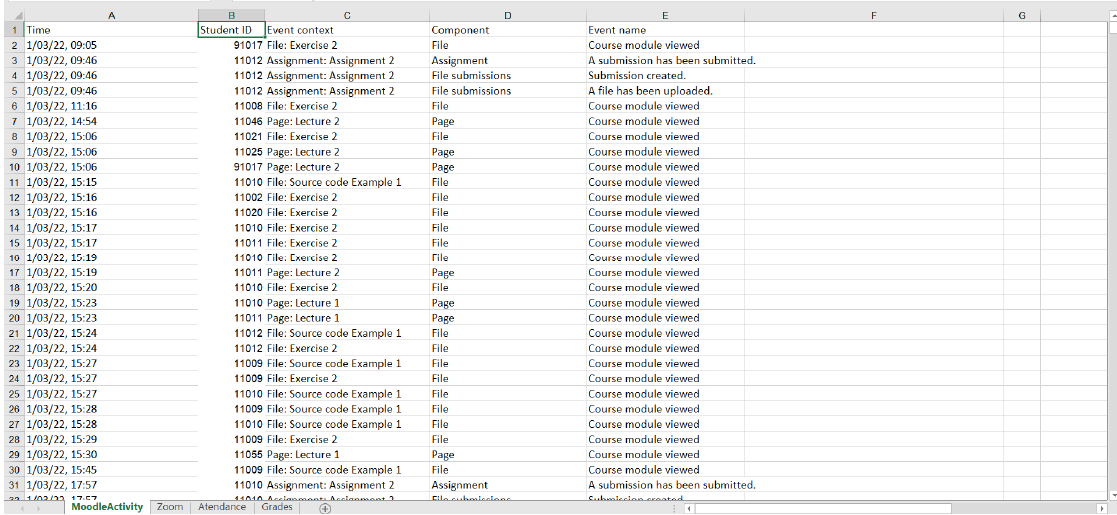
Figure 1. Data from Moodle.